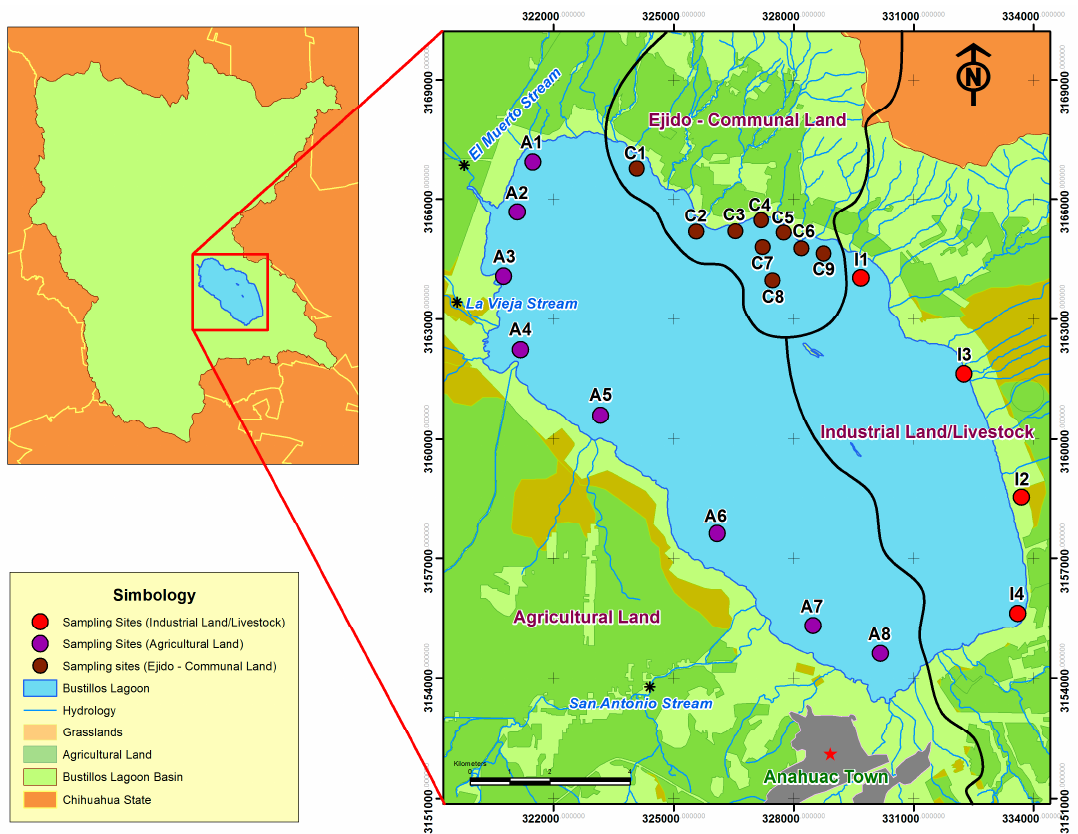
Figure 1. Location of Bustillos Lagoon in Chihuahua, Mexico and sampling sites. Sample codes I =